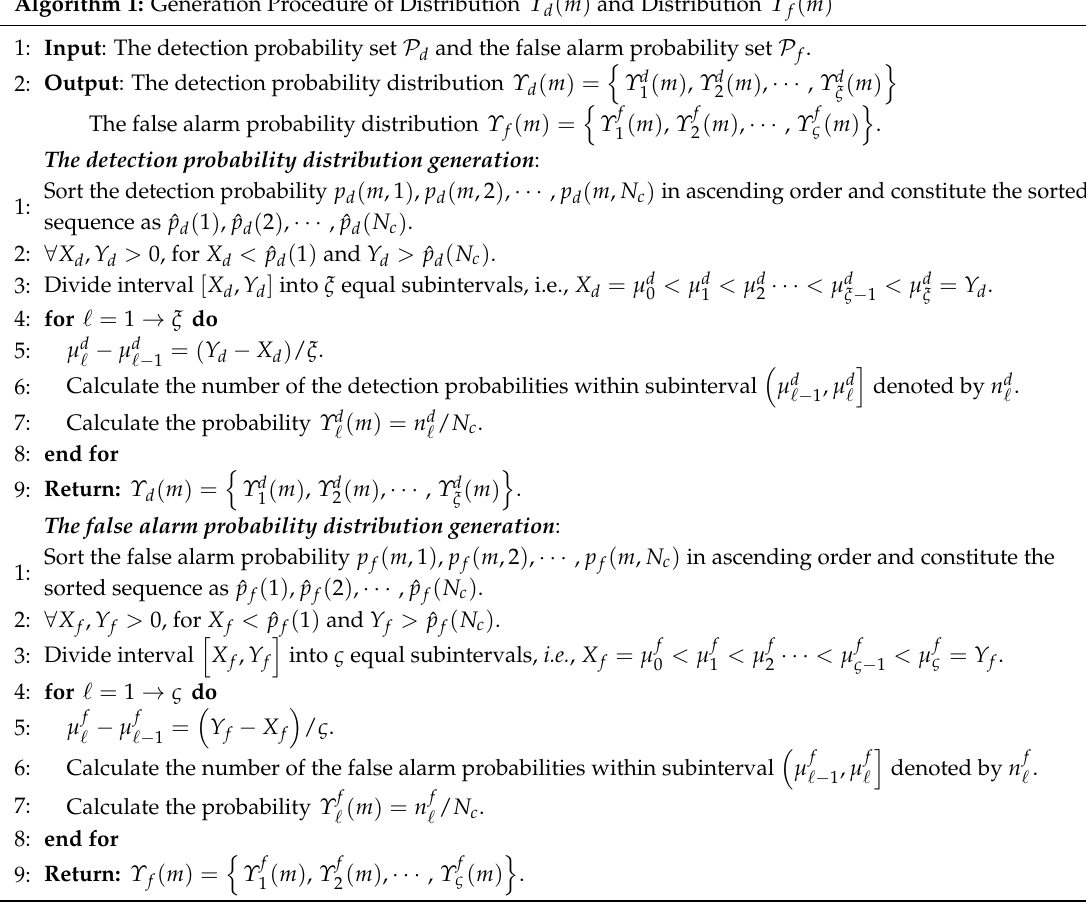
Algorithm 1: Generation Procedure of Distribution Υ d ( m ) and Distribution Υ f ( m